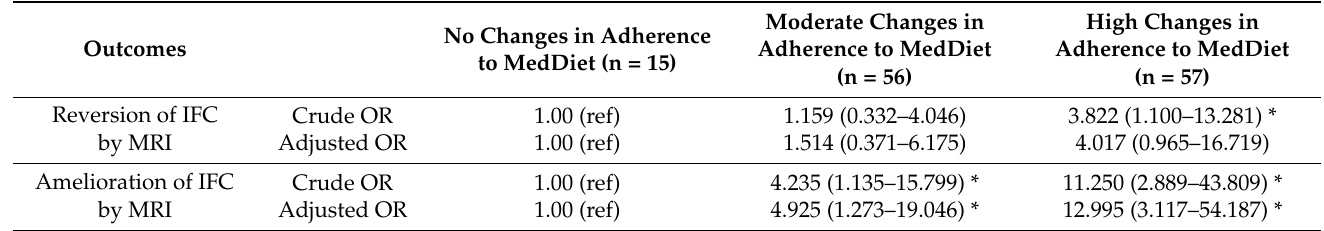
Table 4. Association between the reversion and amelioration of intrahepatic fat contents and the categories of the changes of adherence to MedDiet after 6-month